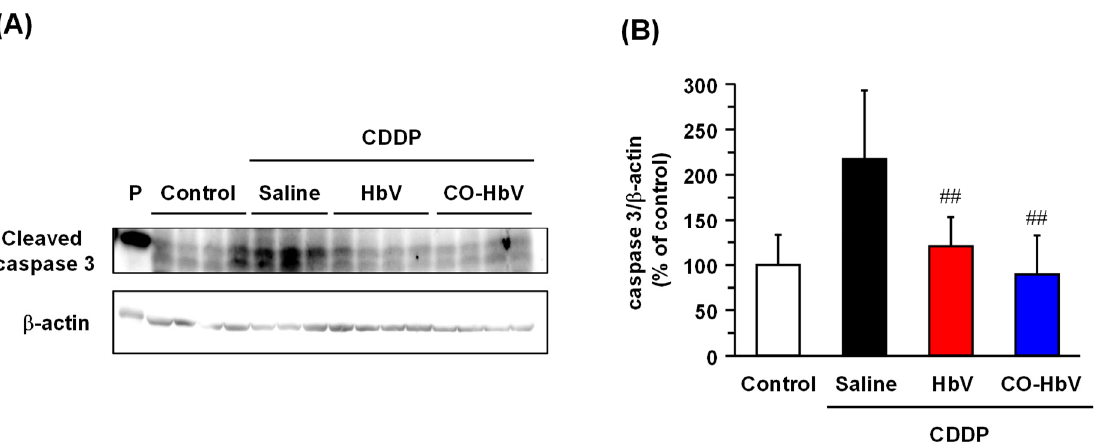
Figure 4. The effect of each treatment on the caspase-3 activation in kidney of cisplatin (CDDP) mouse model. ( A ) Representative protein expression and ( B ) quantitative analysis of band intensity of caspase-3 cleavage protein in kidney at 96 h after sample treatment. The data represents the mean ± S.D. Control ( n = 8), Saline ( n = 7), Hemoglobin-vesicle (HbV) ( n = 8), carbon monoxide (CO)-loaded HbV (CO-HbV) ( n = 8); ## p < 0.01 vs. Saline. P; positive control .